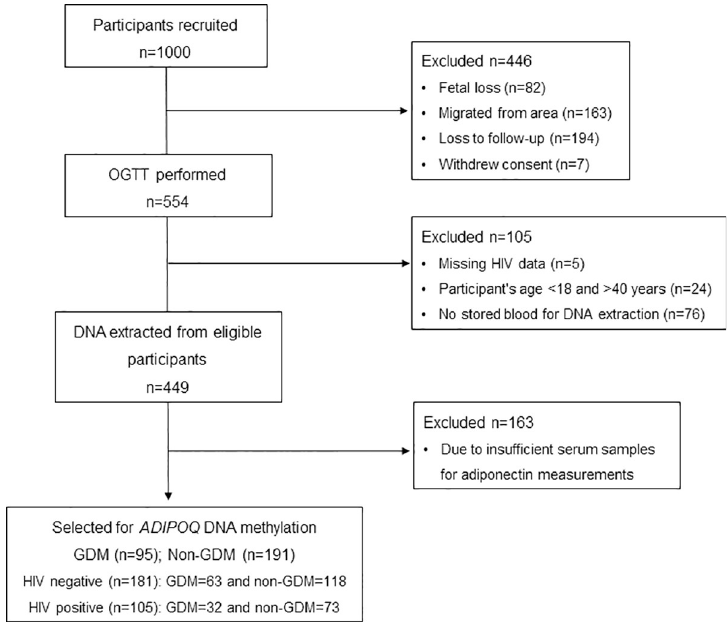
Fig 1. Flow diagram for study participants. A subset of women with (n = 95) and without (n = 191) GDM were selected for this cross-sectional study and were stratified according to HIV negative and HIV positive groups. HIV: Human Immunodeficiency